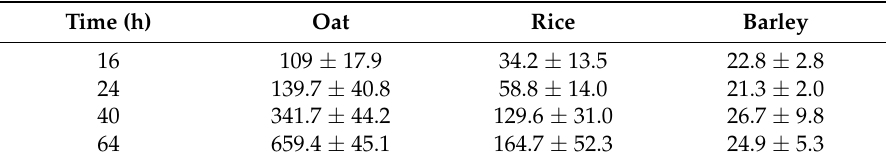
Figure 1. Fermentation of oat (square) and rice (triangle) matrices by Pediococcus parvulus 2.6 (black symbols) and 2.6NR (white symbols) strains. The evolution of bacterial viability (continuous line) and the pH of the matrices (dashed line) were monitored over a 64 h period. Table 1. Quantification of O 2-substituted (1,3)- β - D -glucan (mg · L − 1 ) production in oat, rice, and barley flours fermented by P. parvulus 2.6. Three independent experiments were performed in duplicate.